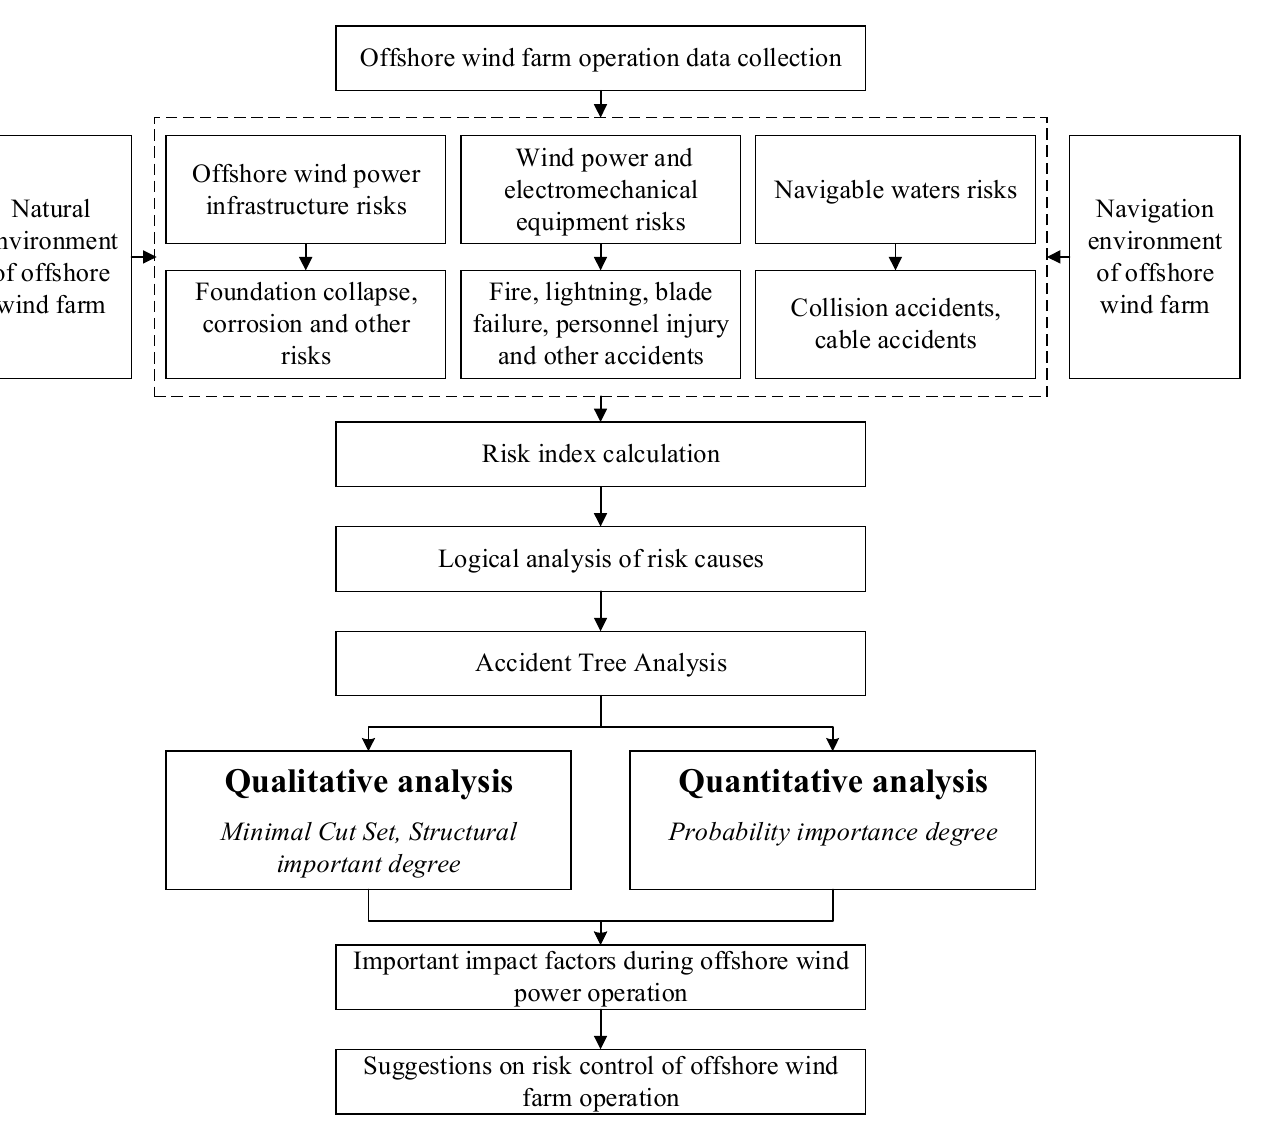
Figure 1. Methodology. Figure 1.